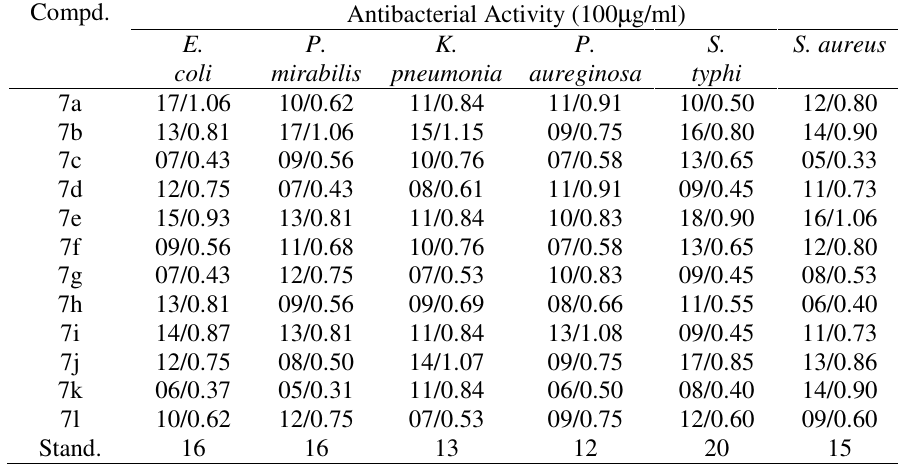
Table1 . Antimicrobial activity of synthesized compounds 7a-l Zone of inhibition (mm)/(activity index)